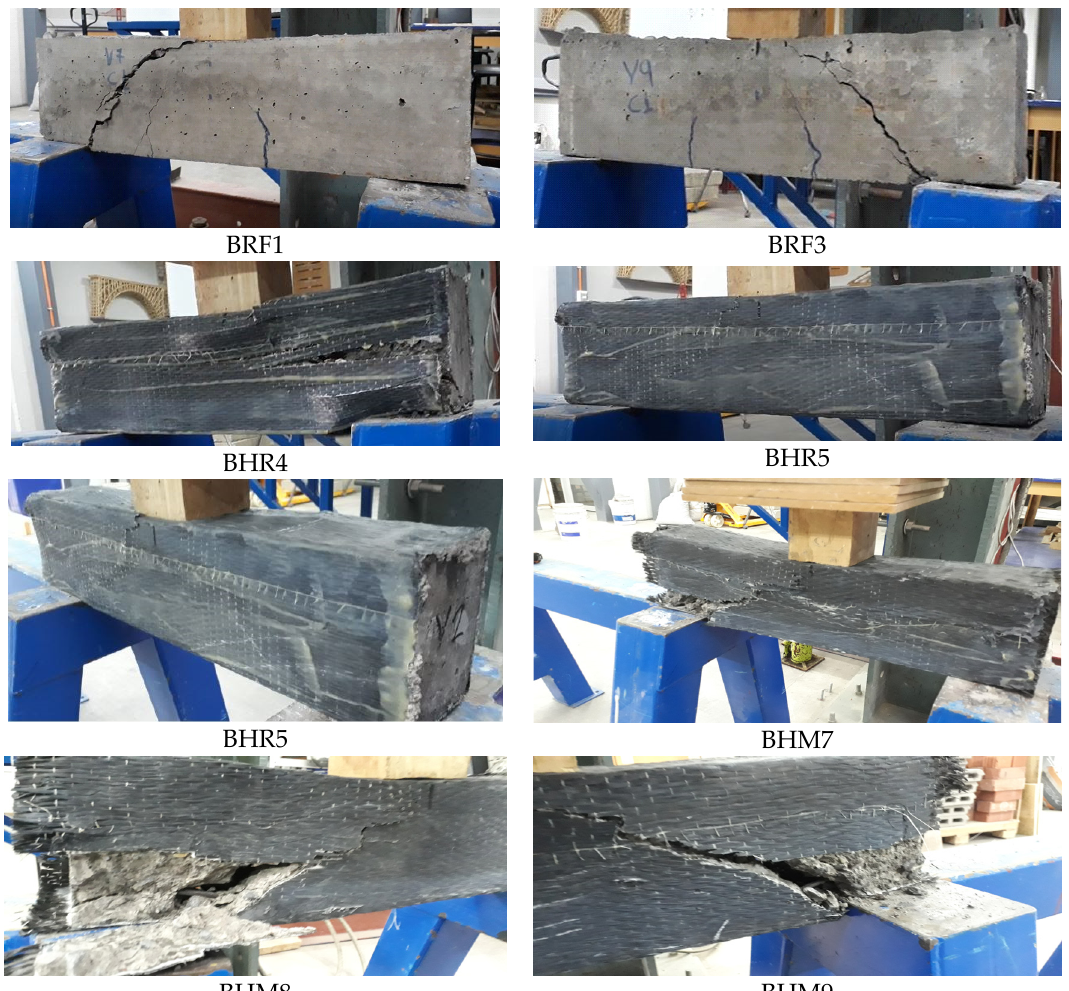
Figure 5. Images of the beams after flexural strength testing.